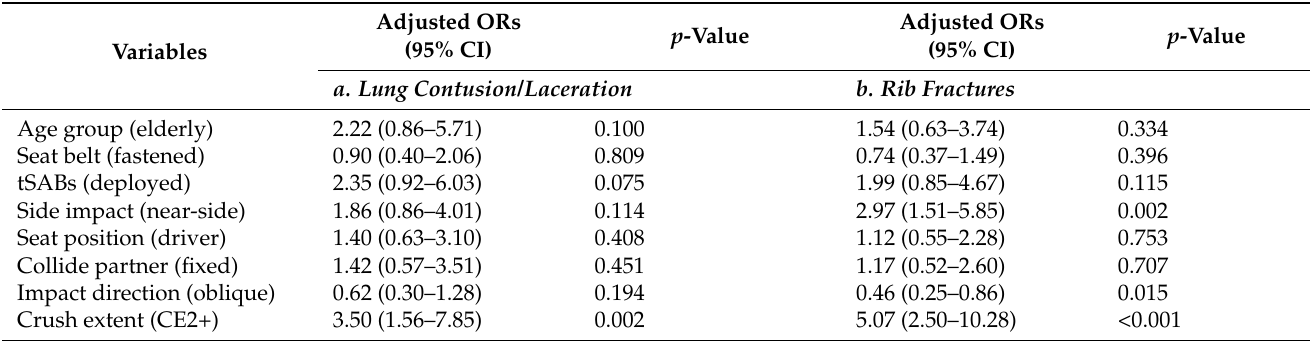
Table 4. Multiple logistic regression analysis associated with lung injury and rib fracture injuries (AIS ≥ 2) in side